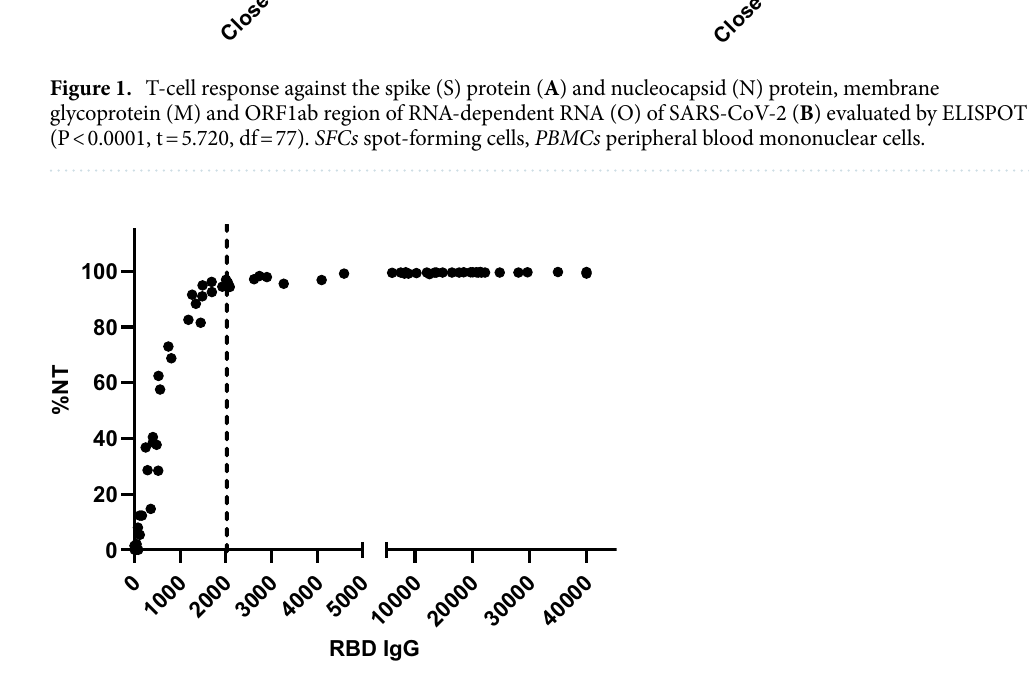
Figure 2. The antibody response to RBD IgG demonstrates the correlation between the antibody levels and neutralization capacity against the Alpha variant of SARS-CoV-2 (R = 0.5571, P <